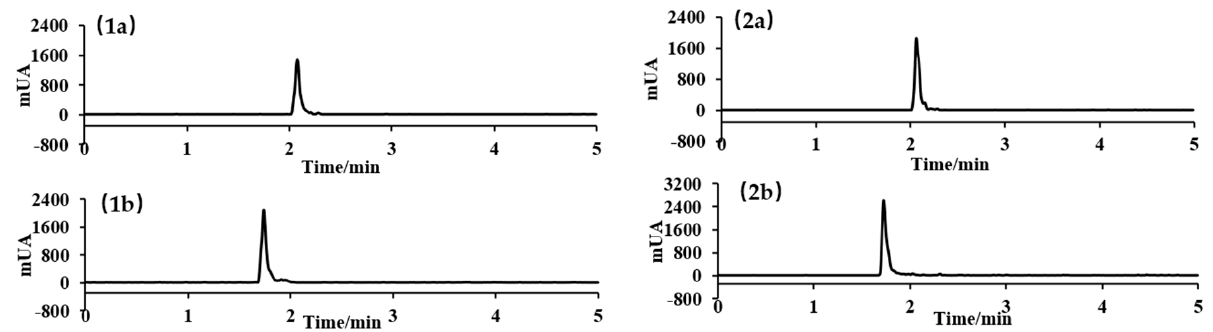
Figure 2. Ultra-performance liquid chromatography–tandem mass spectrometry (UPLC-MS/MS) profiles of the standards ( 1 ) and LACCE ( 2 ). The letters in the profiles represent the following: ( a ) leontopodic acid A, ( b ) leontopodic acid B. Table 2. Calibration data and sensitivity of UPLC-MS/MS.